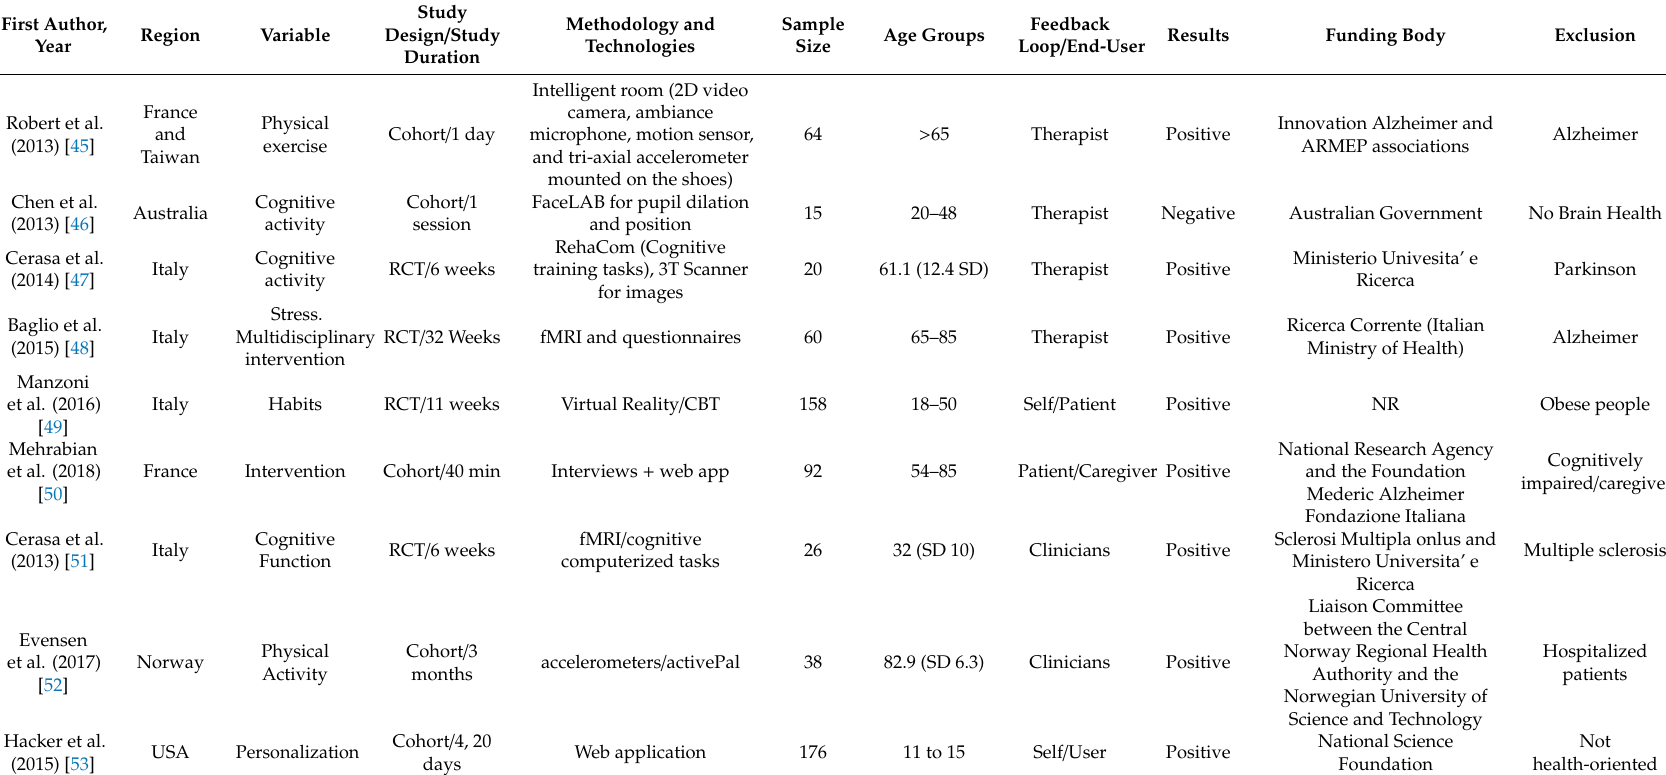
Table 3. Out of criteria included